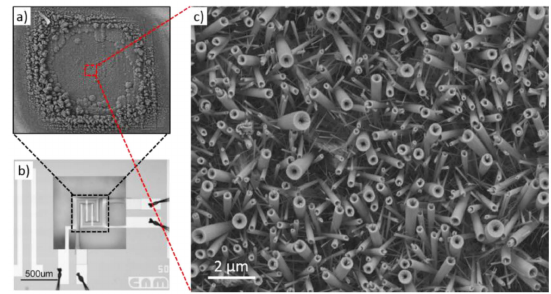
Figure 1. Scanning electron microscope images of WO 3 nanostructures grown at ( a ) low and ( b , c ) high magnification grown localized on microhotplates via AACVD. Adapted from